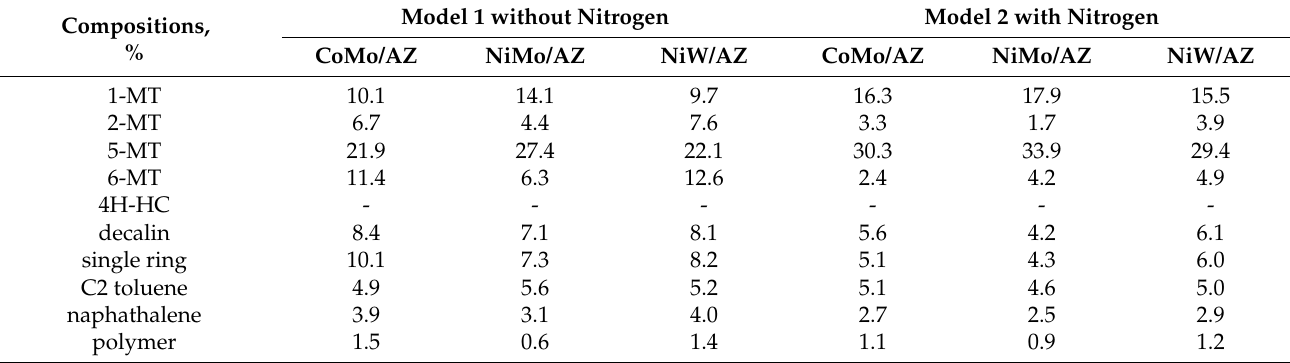
Table 4. Chemical compositions of 1-MN hydrogenated products at 480 min.